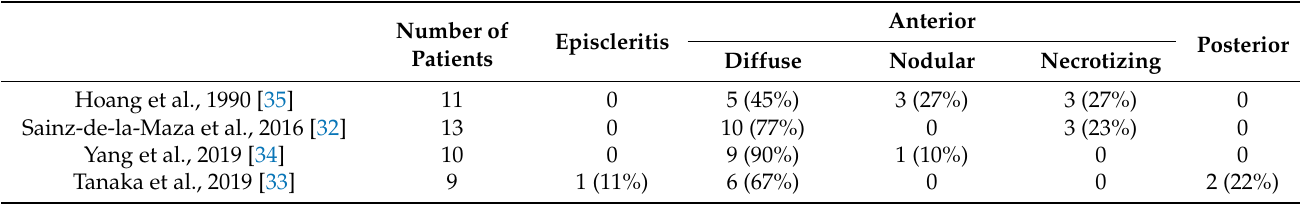
Table 4. Types of scleritis in previous case series.